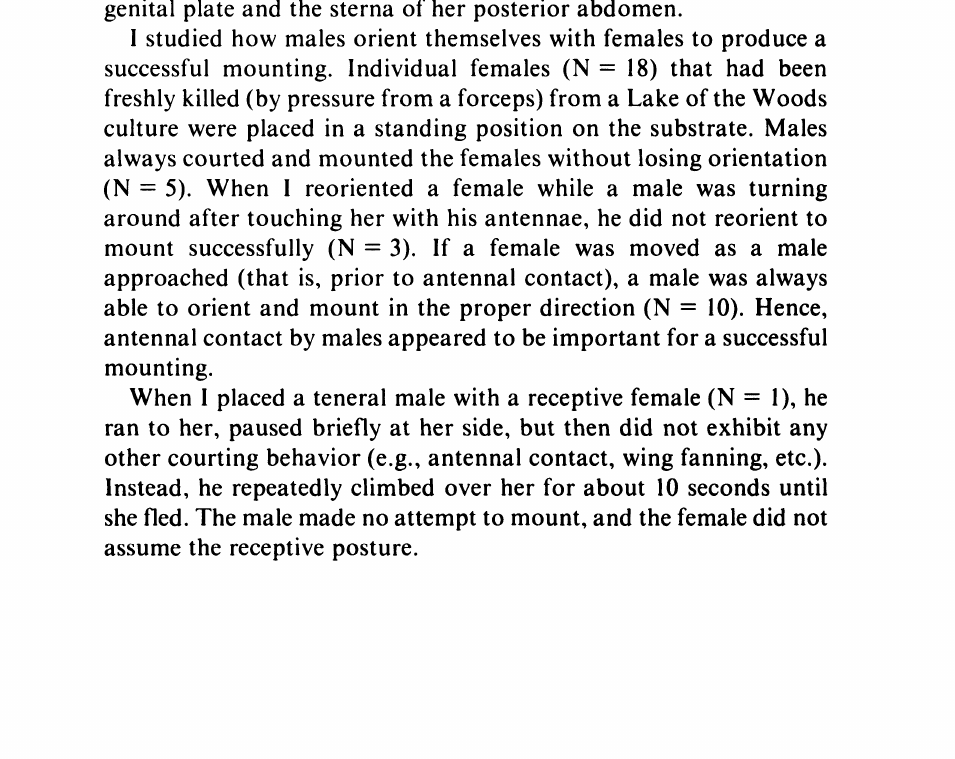
Figure 2. Typical precopulatory behavior in Trichadenotecnum alexanderae. a.. A male in position to move beneath a female, b. The receptive posture of a